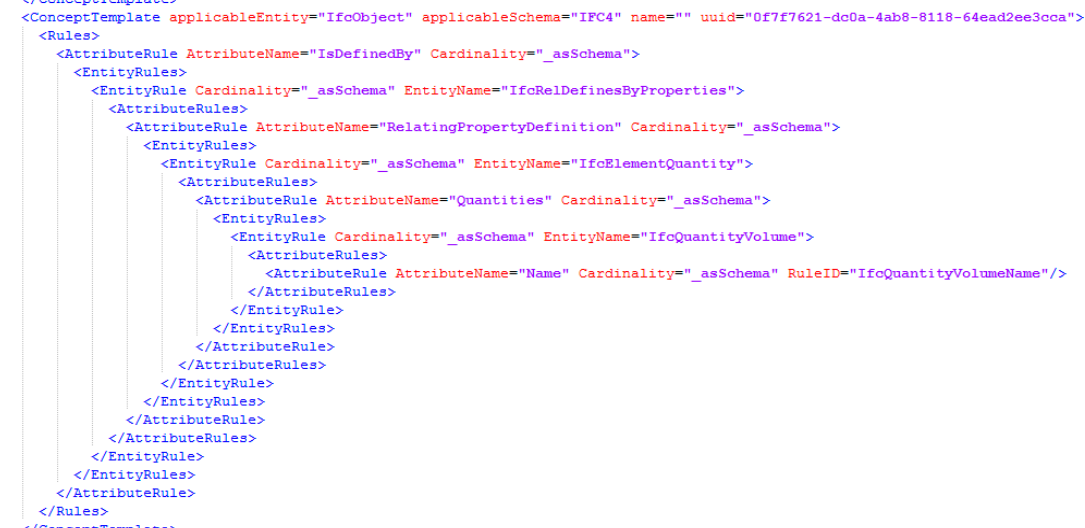
Figure 5. Example of ConceptTemplate.